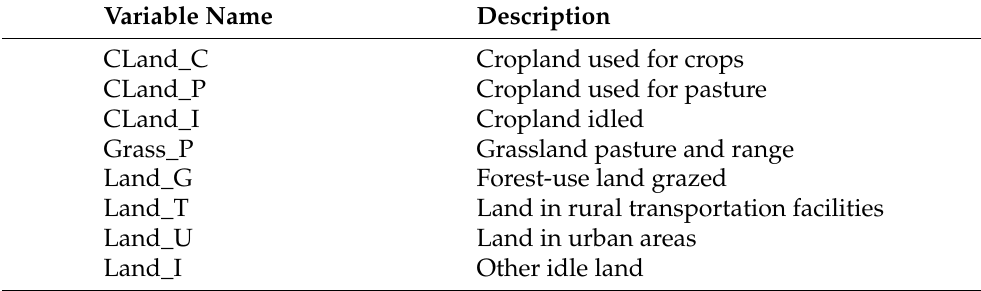
Table 8. Summary of